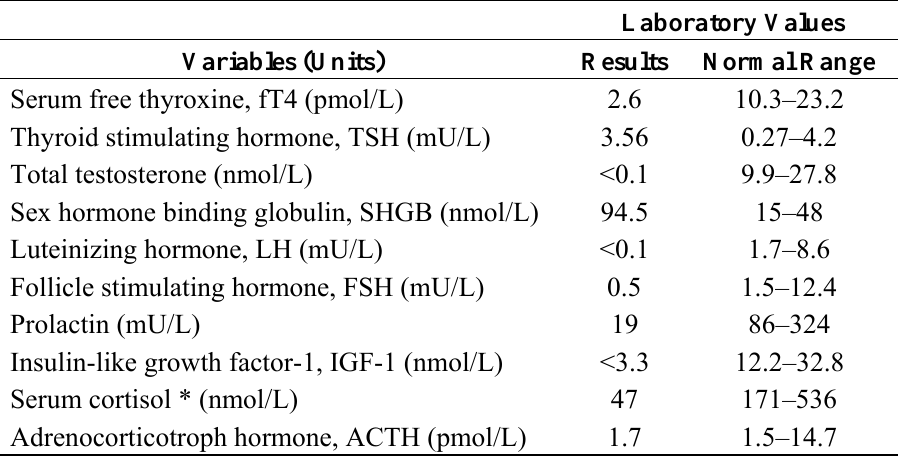
Table 1. Results of the basal hormone levels of the